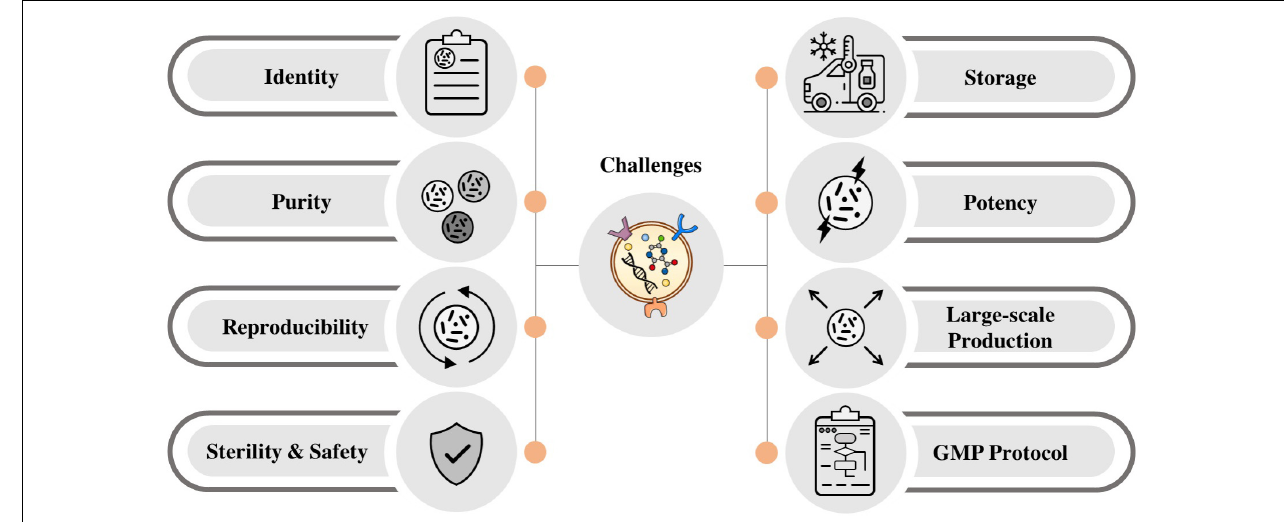
FIGURE 3 | Main challenges for the application of stem cell-derived EVs in